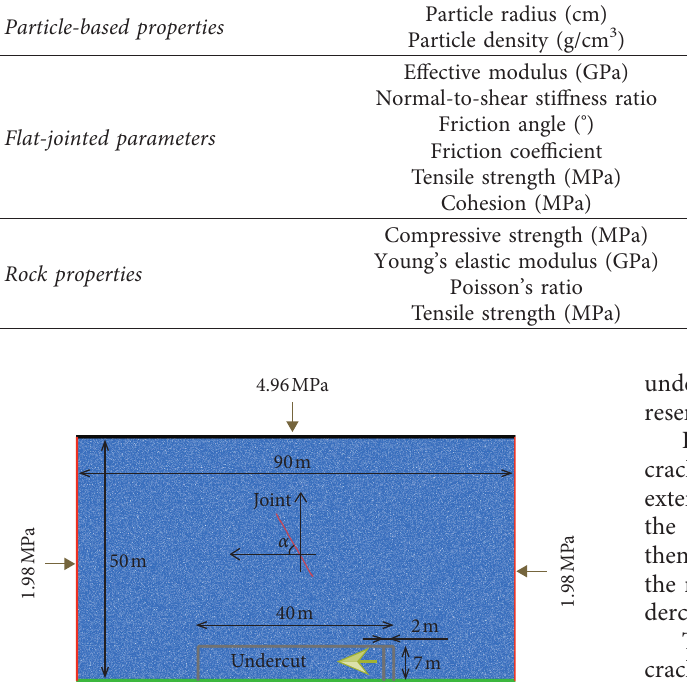
Figure 4: Design of the numerical